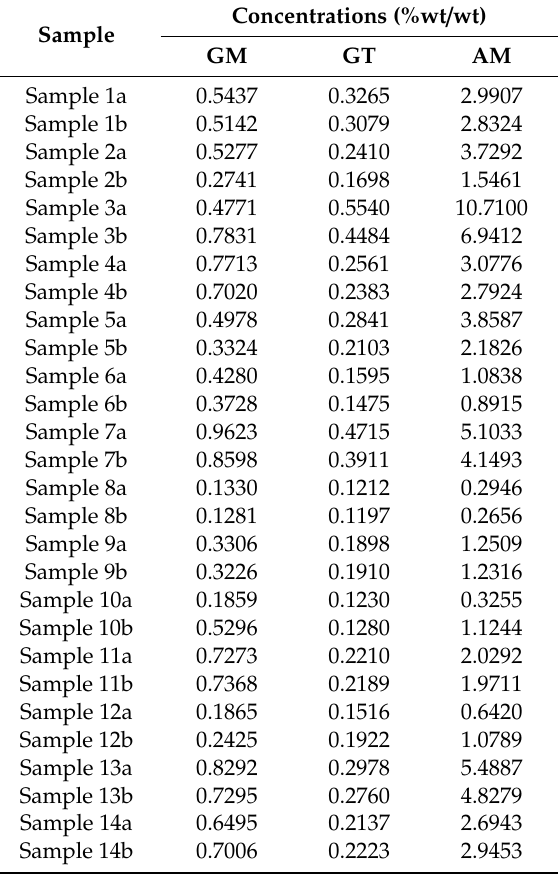
Table 2. Concentrations of γ -mangostin (GM), gartanin (GT), and α -mangostin (AM) in mangosteen pericarp.